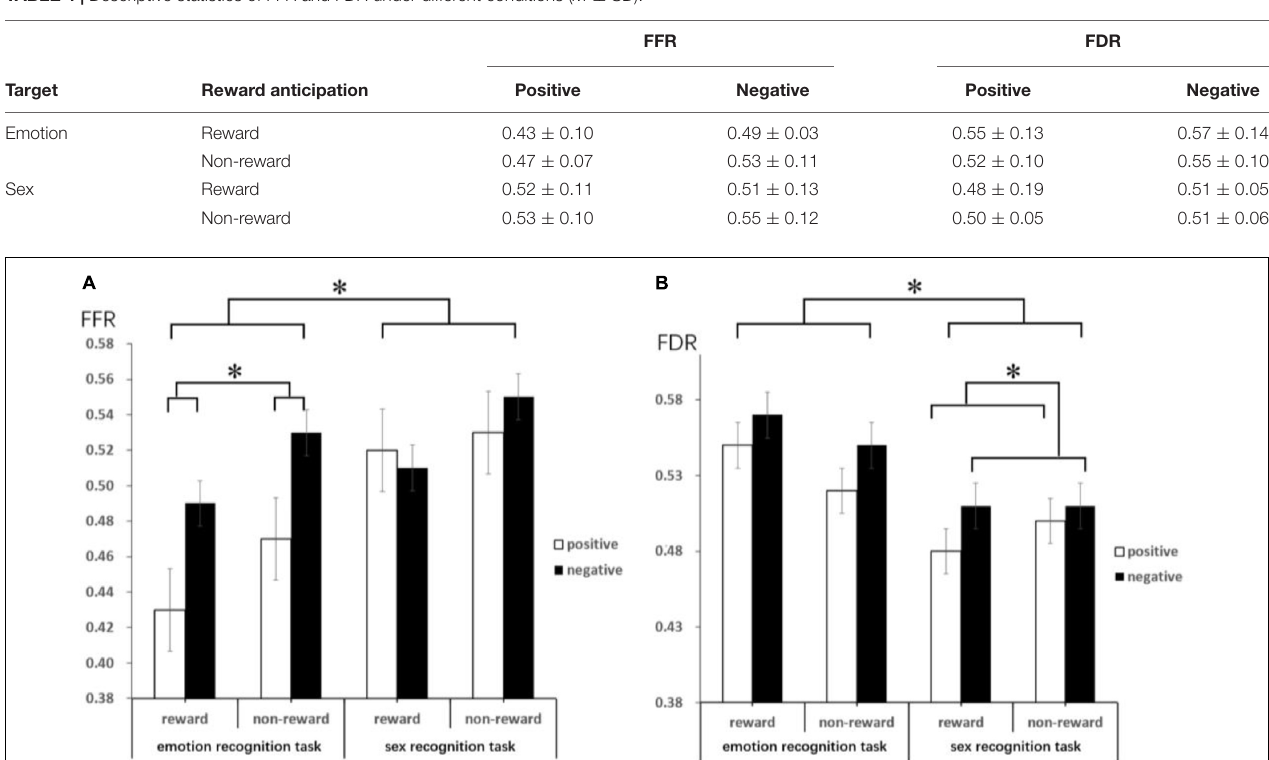
TABLE 4 | Descriptive statistics of FFR and FDR under different conditions ( M ±